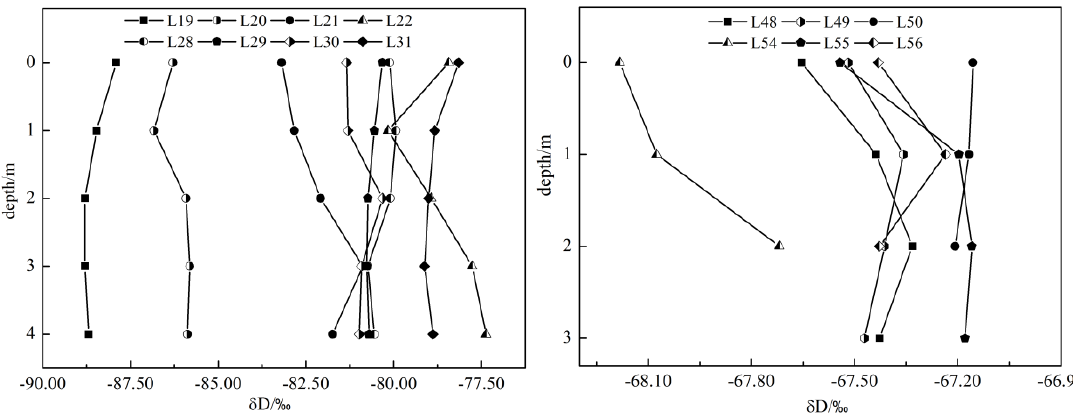
Figure 7. Hydrogen isotope composition with depth profiles in August 2014 ( left ) and April ( right ) 2015, respectively.